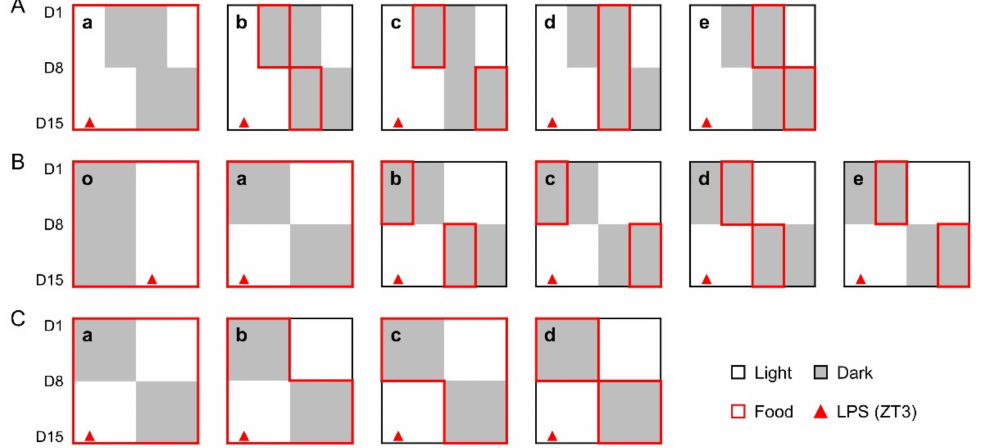
Figure 1. Study design. ( A ), The mice in experiment 1 were treated with a 6-h delayed phase shift, combined with or without 6-h TRFs; ( B ), The mice in experiment 2 were treated with a 12-h phase shift, combined with or without 6-h TRFs; ( C ), The mice in experiment 3 were treated with a 12-h phase shift, combined with or without 12-h TRFs. One week after the relevant shift, mice in all groups were treated with LPS (15 mg/kg body weight, ip) at ZT3. Health status was monitored for 7 days.